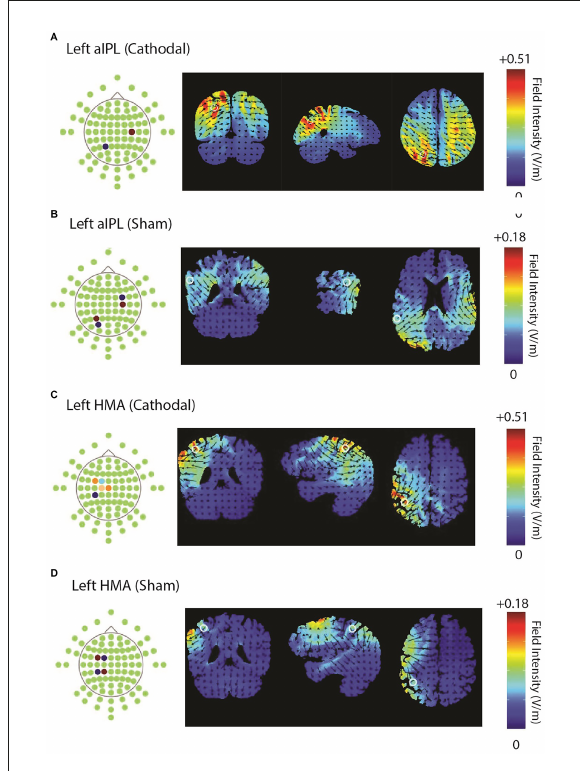
FIGURE1 Illustrates the electrode configurations and modeled flow of current for both active and sham stimulations over aIPL panel (A,B) and HMA panel (C,D)